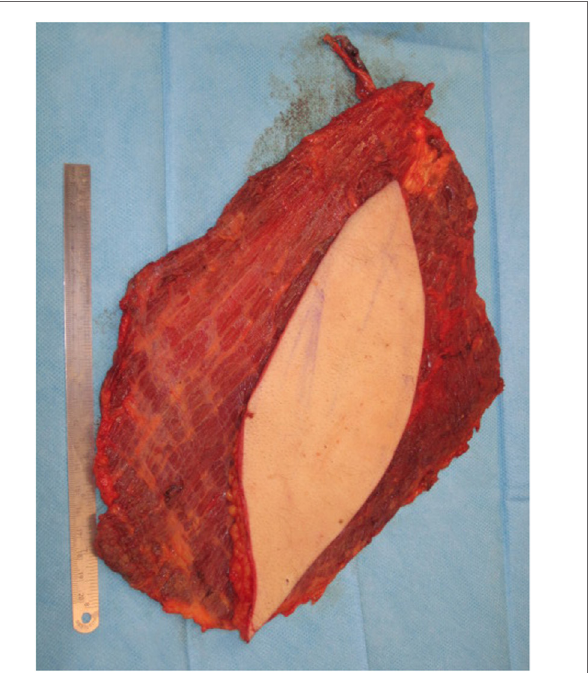
FigUre 6 | Free latissimus dorsi myocutaneous flap harvested, with templated skin paddle and muscle for volumetric filling .